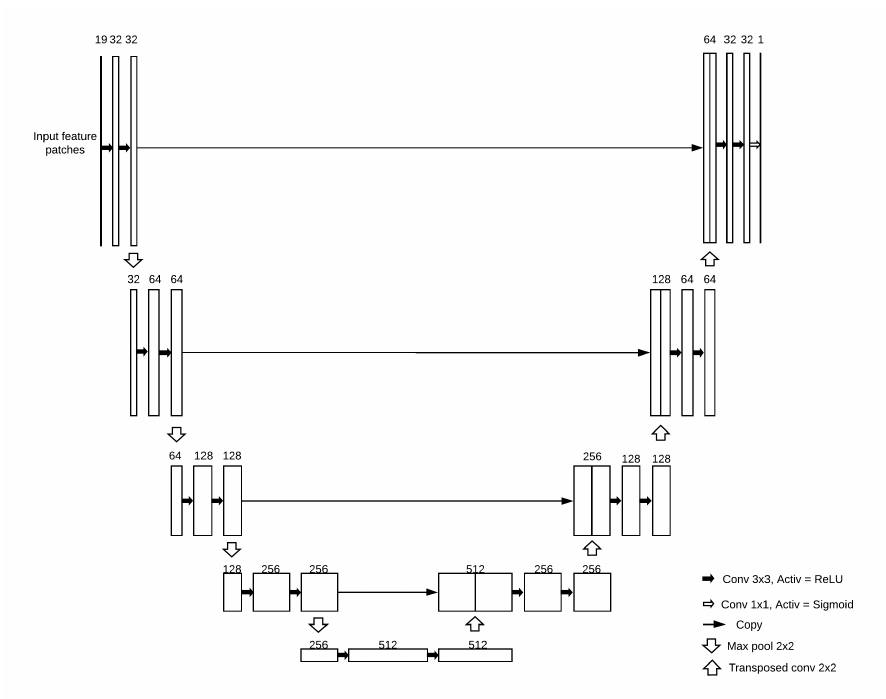
Figure 2. U-Net architecture used for fire